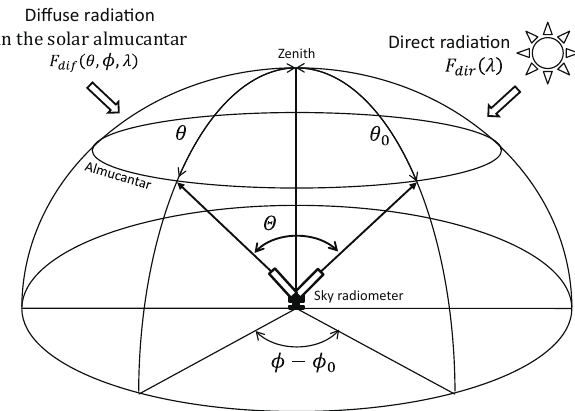
Figure 2. Observation of the sky radiometer in the solar almucantar